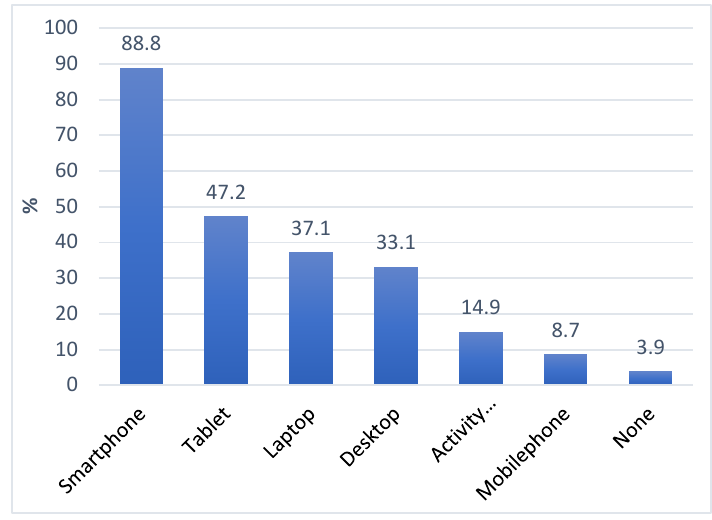
Figure 2. Ownership of technological devices among Chinese immigrants. Table 2. Mean scores for survey items in eHEALS * ( n = 356).